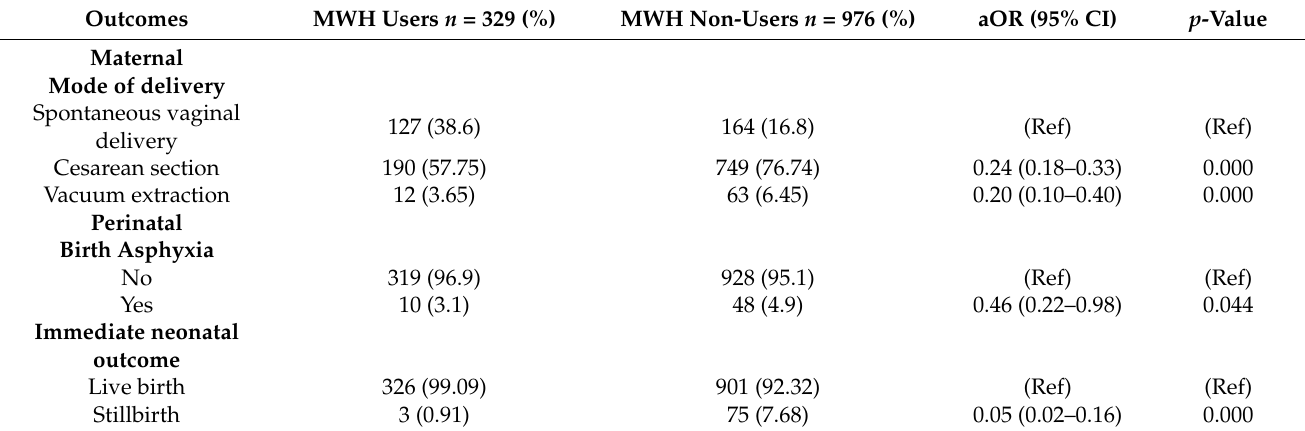
Table 4. Adjusted odds ratios for maternal and perinatal outcomes between users and